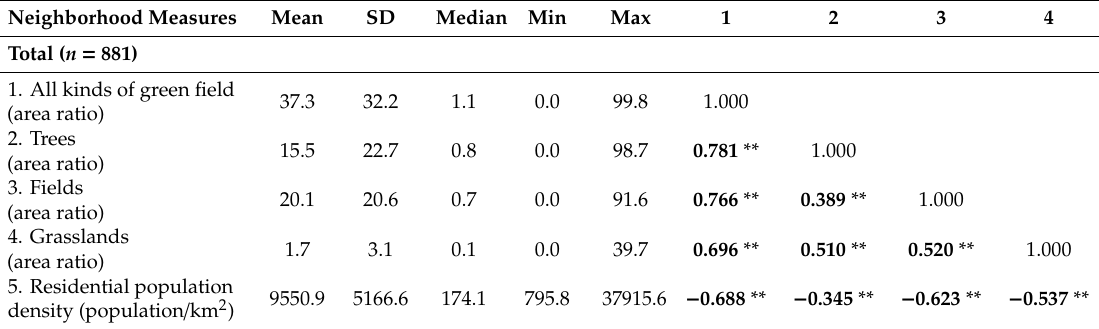
Table 2. Summary of neighborhood measures and their Spearman associations ( n = 881).